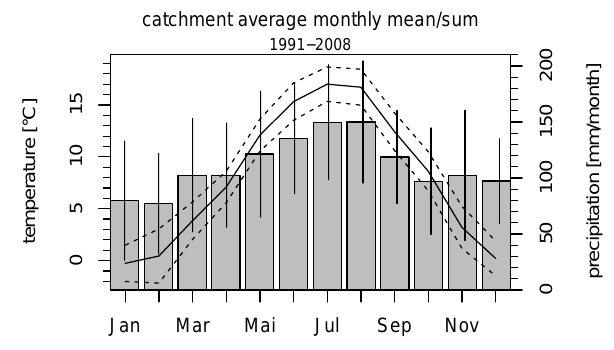
Fig. 1. Thur catchment average mean monthly temperature (solid line) and precipitation sum (bars) in the study period 1991–2008. The dashed lines and vertical bars show one standard